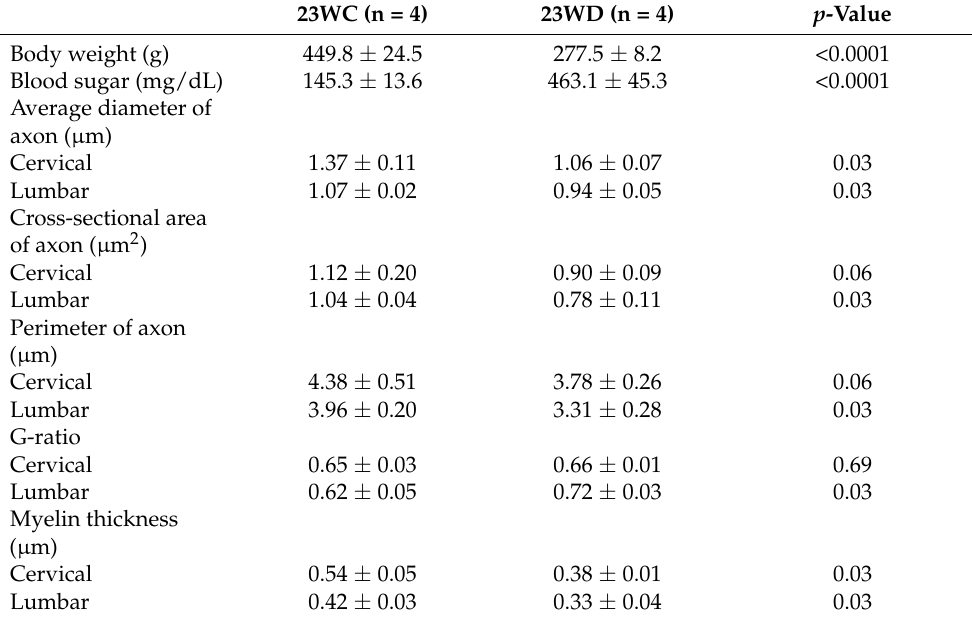
Table 2. Body weights, blood glucose levels, and morphological data for BDF fibers in animals used for morphometric